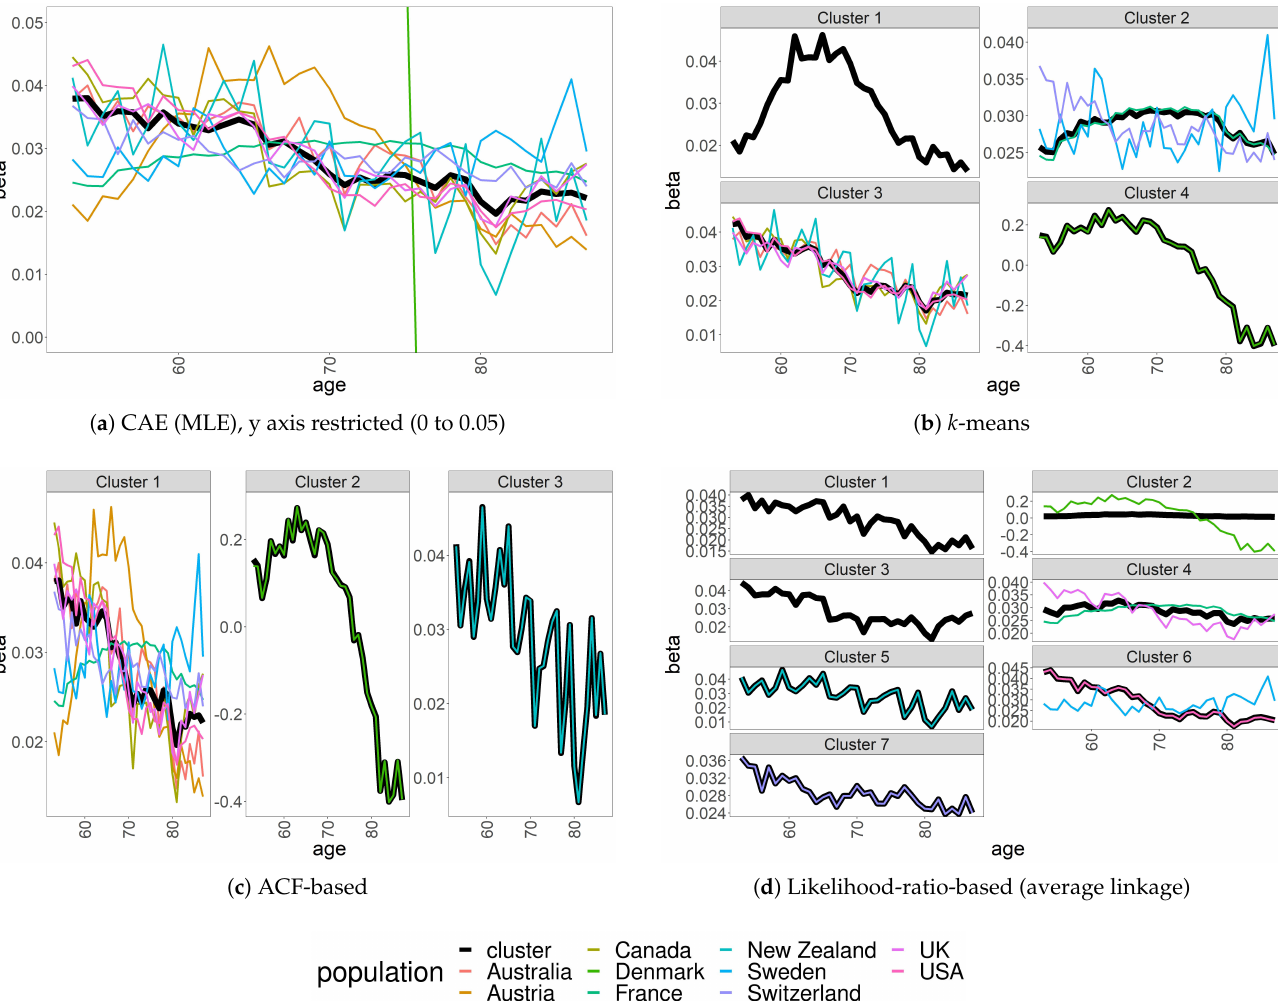
Figure 3. Age effects by cluster for males aged 53 to 87 in 10 countries between 1948 and 1987 obtained by the common age effect (CAE) model and three of its clustering-based extensions. The age effects of the clusters are displayed in black and the individual Lee–Carter (ILC) age effects of the populations are in different